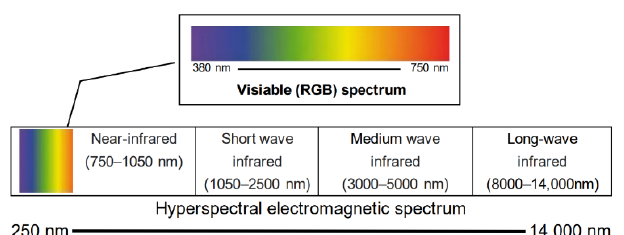
Figure 1. Depiction of the different wavelength ranges of visible color imaging and hyperspectral imaging. The wavelength range of visible light is from approximately 380 to 750 nm, a small portion of the range of HSI.